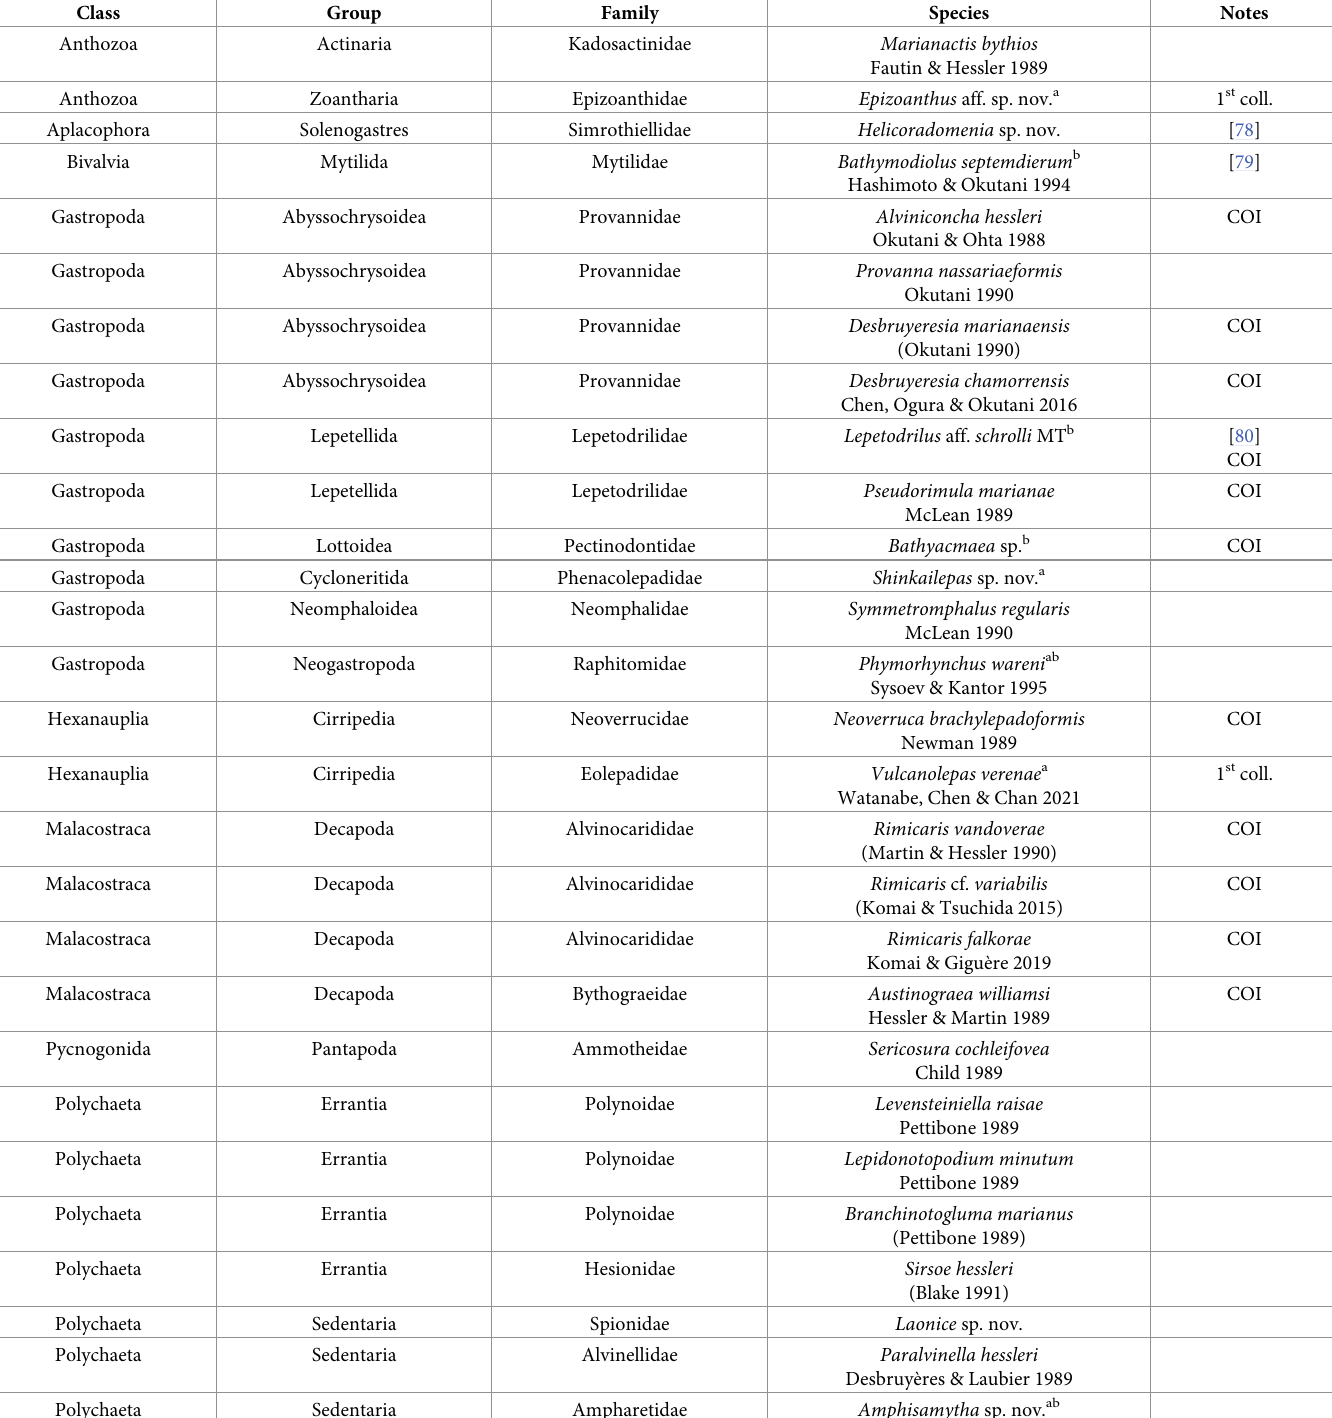
Table 2. Macrofauna collected from the four northern-most vent sites in the Mariana